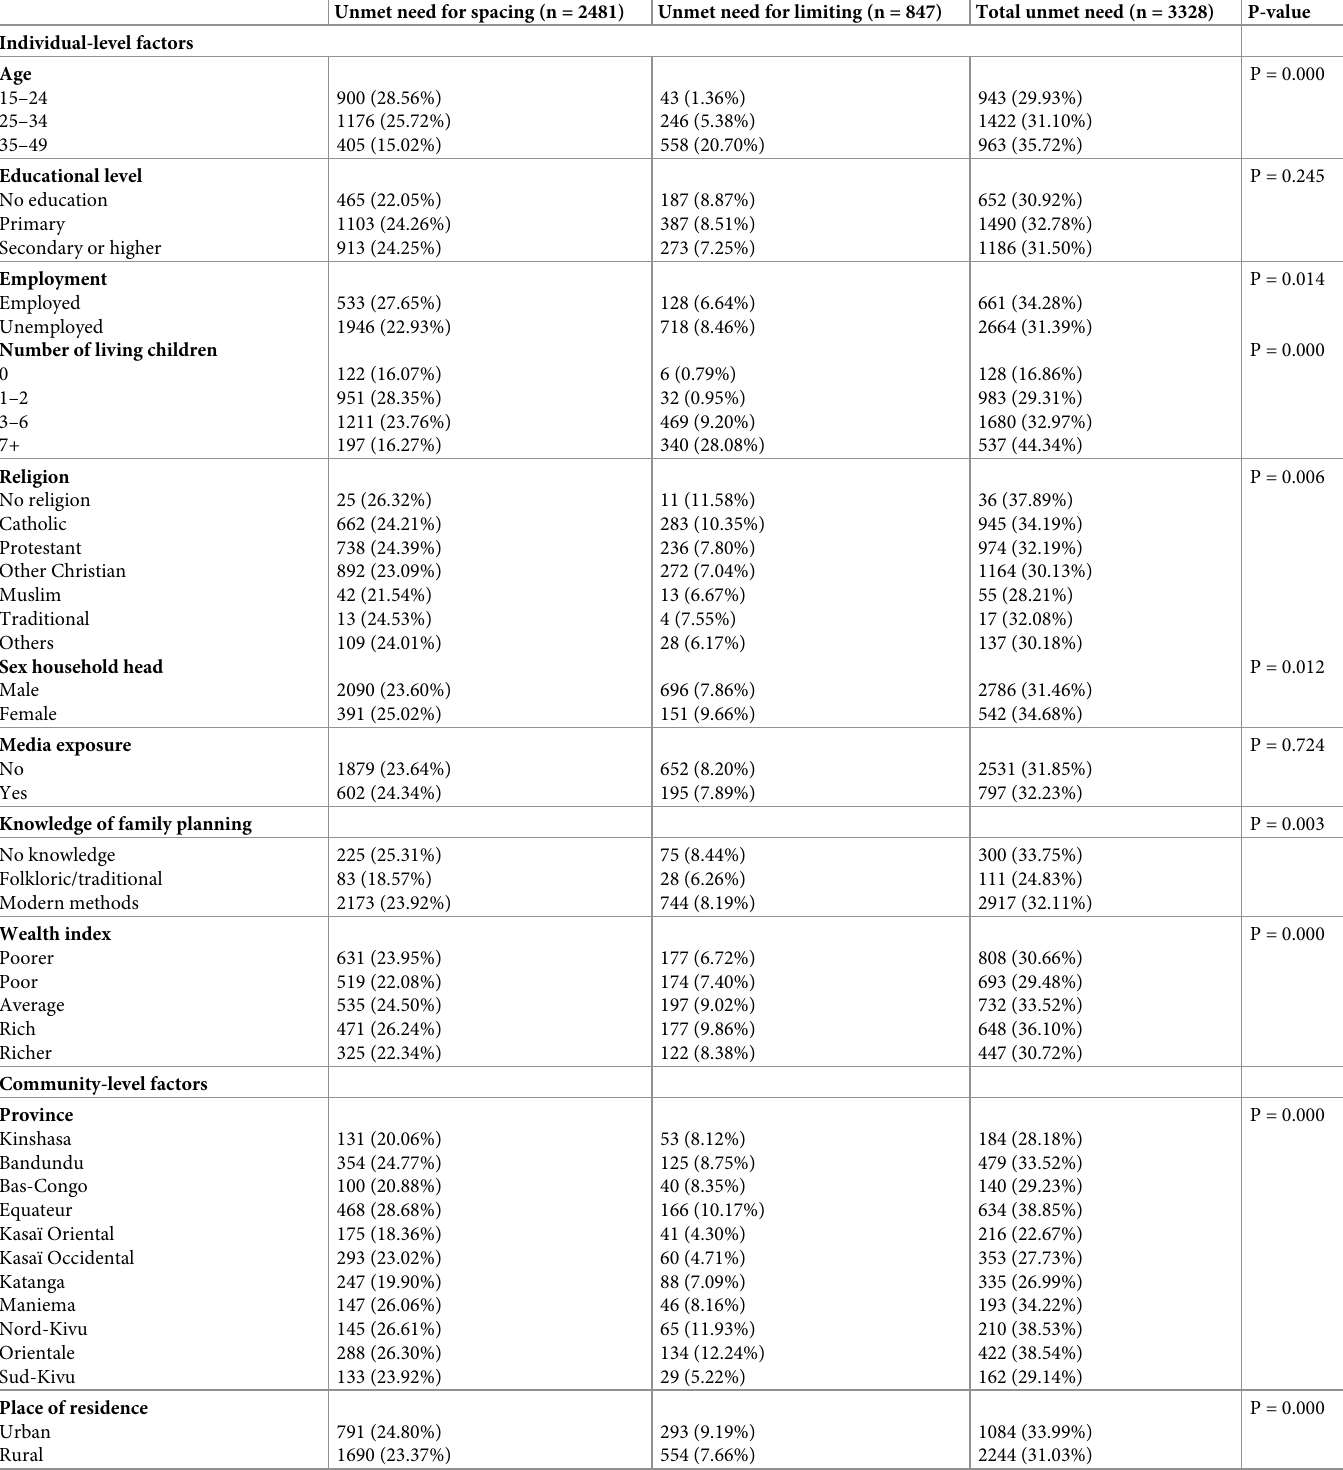
Table 1. a. Prevalence of unmet need for family planning among married or in union women (n = 10415), individual-level factors. b. Prevalence of unmet need for family planning among married or in union women (n = 10415), community-level